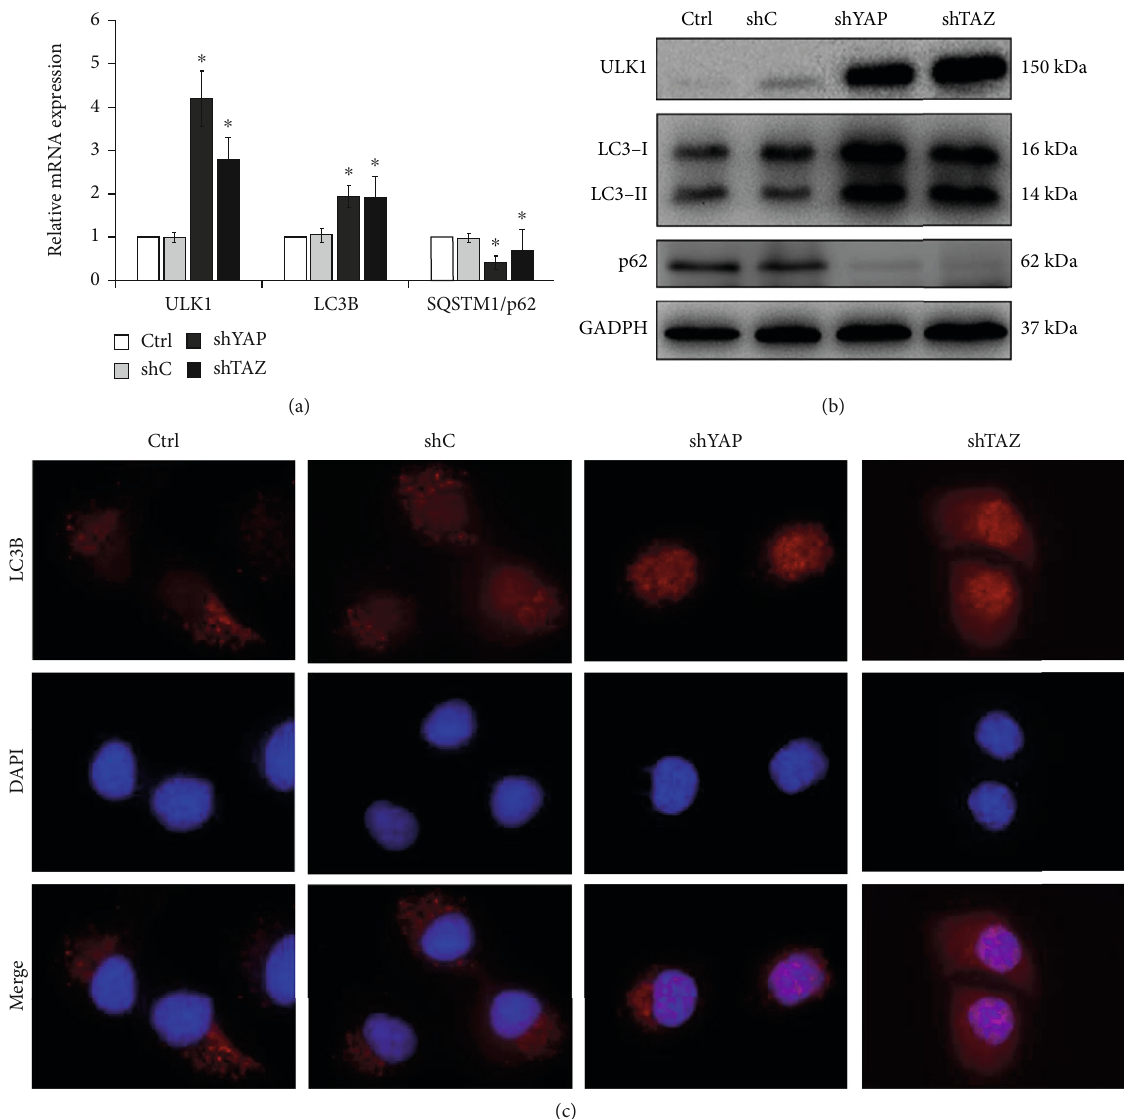
Figure 5: Knockdown of YAP or TAZ promoted autophagic activity in RA-FLS. (a) Quantitative analysis of mRNA levels of autophagy- related genes in stable YAP or TAZ knockdown RA-FLS by RT-qPCR and normalized against GAPDH. Data were shown as the mean ± SD ( n = 4 ). ∗ P < 0 : 05 relative to shC by Student ’ s t -test. (b) Protein levels of ULK1, LC3B, and p62 were determined by western blot in stable YAP or TAZ knockdown RA-FLS, and GAPDH was used as a loading control. Representative blots are shown ( n = 3 ). (c) LC3B puncta detected by immuno fl uorescence staining assay in stable YAP or TAZ knockdown RA-FLS ( n = 3 ). Magni fi cation, ×